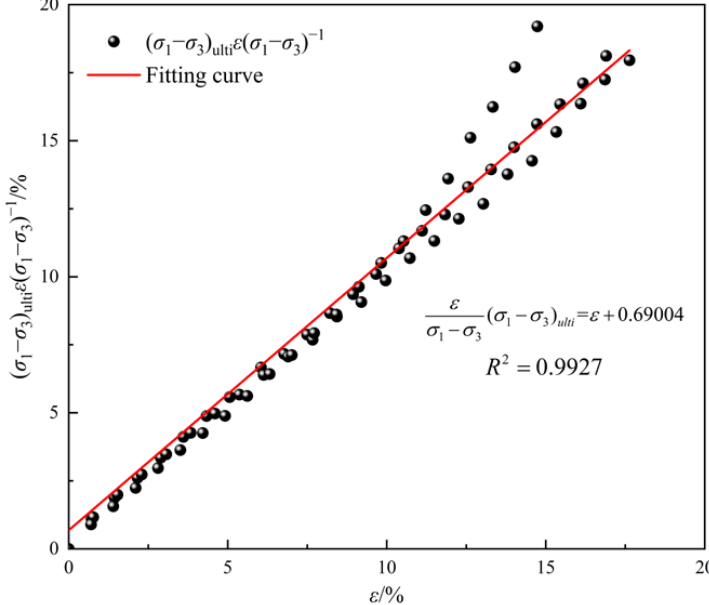
Figure 12. Normalized stress–strain curves with